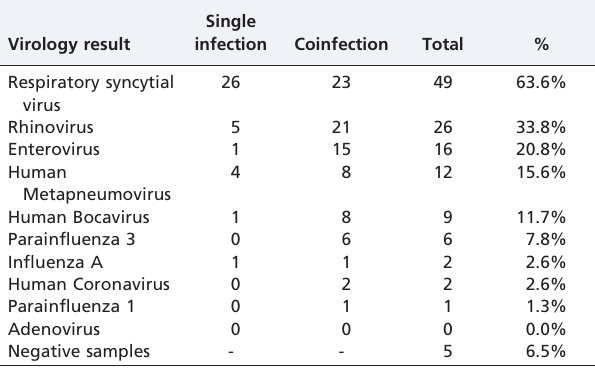
Table 2 - Respiratory viruses identified in nasopharyngeal aspirates of infants with bronchiolitis (n= 77).